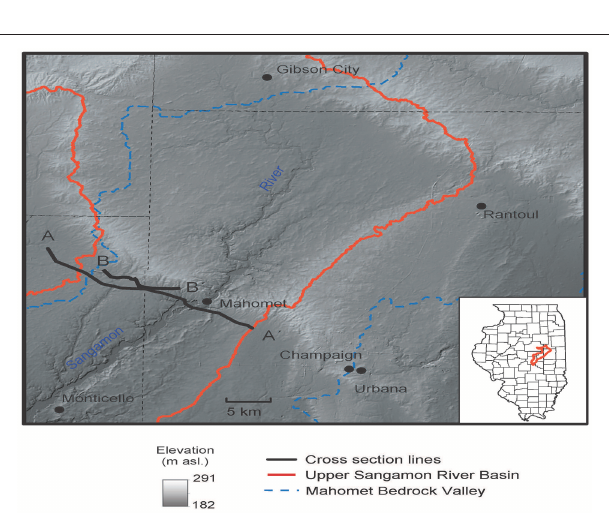
FIGURE 4 | Digital elevation map of a portion of east-central Illinois, showing the locations of cross sections (A–A ′ ) and (B–B ′ ) in the USRB with respect to the buried Mahomet Valley. Surface expression of constructional glacial topography (moraines) is dominant. The moraines were formed between about 24 and 21 ka, as a fluctuating glacial ice margin receded to the northeast (Caron and Curry, 2016; Grimley, 2016a). Late-glacial and postglacial river valleys (e.g., Sangamon Valley) are dissected into the glacial topography and have fills of outwash and